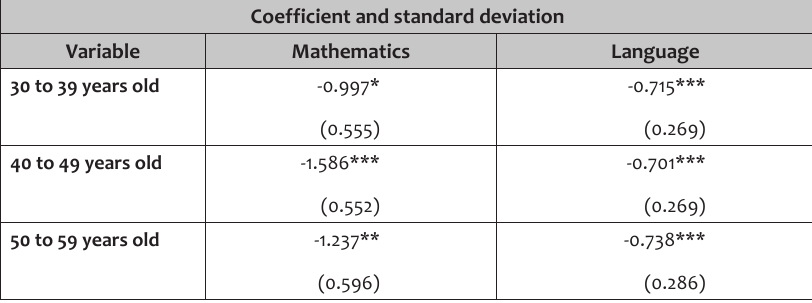
Table 3: Regression of teacher test performance on teacher age (Source: